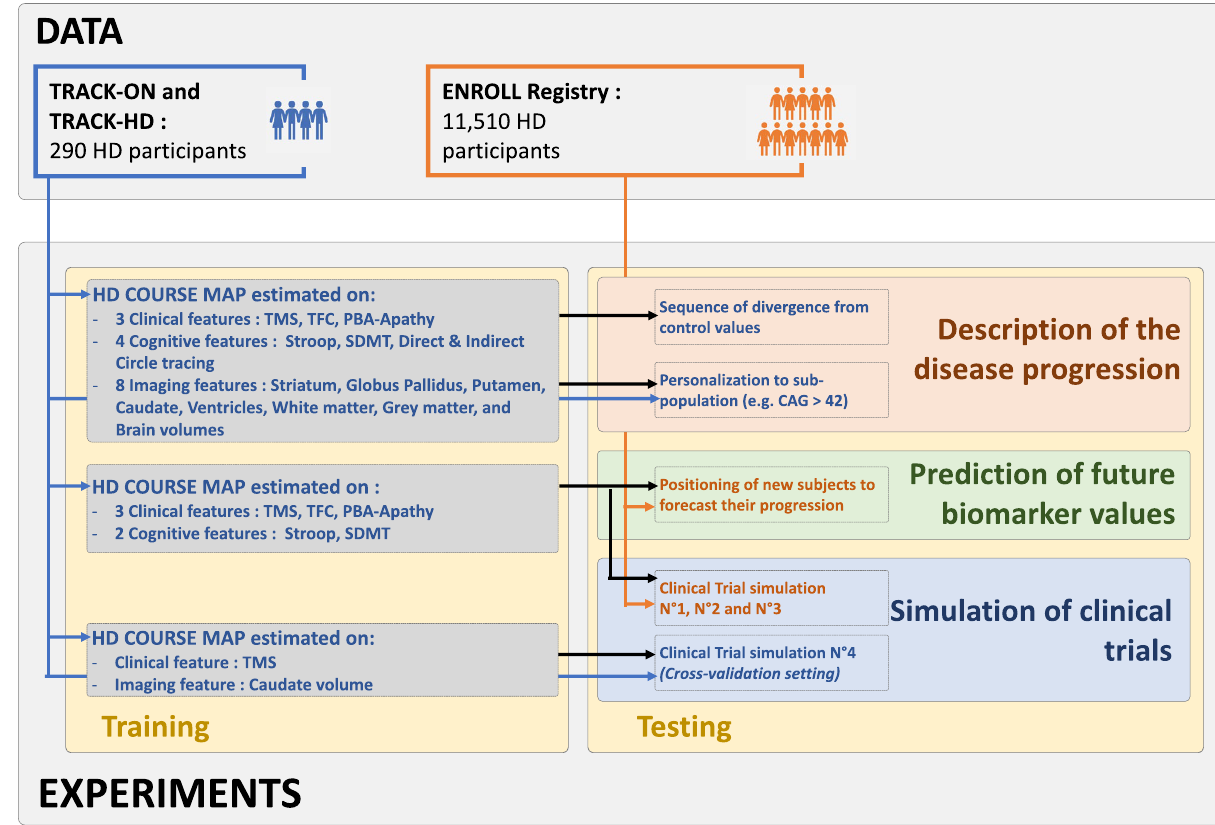
Figure 1. HD COURSE MAP is trained on 290 participants from TRACK studies and tested on independent 11,510 participants from ENROLL-HD. Description of disease progression is based on HD COURSE MAP calibrated on 15 biomarkers. Forecasts of biomarker progression and selection in trials are based on HD COURSE MAP calibrated on the 5 biomarkers that are present in both TRACK and ENROLL. Forecasts of imaging biomarkers are validated on TRACK data only using a cross-validation